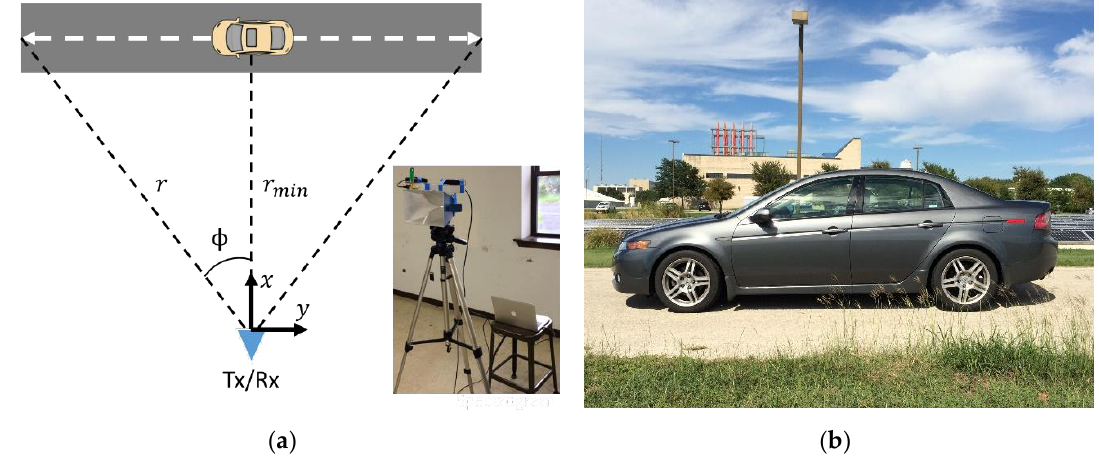
Figure 1. Vehicle measurement setup. ( a ) Measurement collection setup; ( b ) Test vehicle.